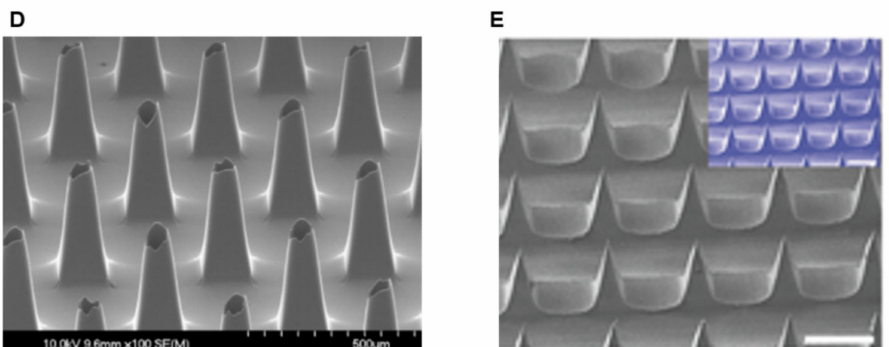
Figure 3. SEM images of solid, hollow, and hydrogel MNs fabricated by different techniques. ( A ) Solid MNs fabricated through injection moulding [89]. ( B ) Solid MNs made via deep reactive ion etching (DRIE) with various tip profiles: ( a ) tapered tip; ( b ) tapered tip plus short Bosch etch; ( c ) tapered tip plus longer Bosch etch. The scale bar is 10 µ m. [90]. ( C ) Solid MNs produced via wet chemical etchant [91]. ( D ) Hollow MNs produced by DRIE and plasma etching [92]. ( E ) Hydrogel MNs fabricated by casting method. The scale bar is 500 µ m [93]. The figures were reproduced with permissions from References [89–93],